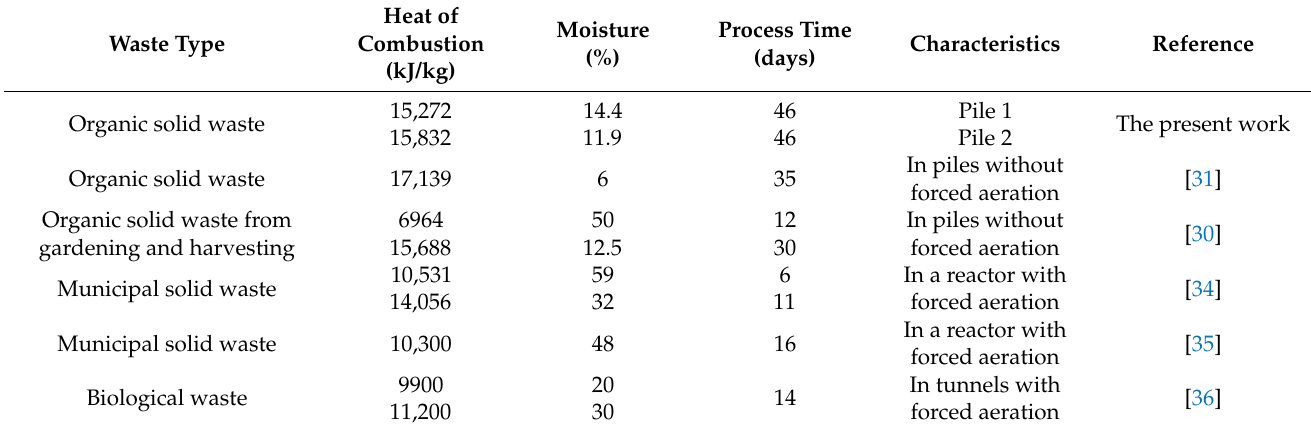
Table 7. Heat of combustion of solid waste after